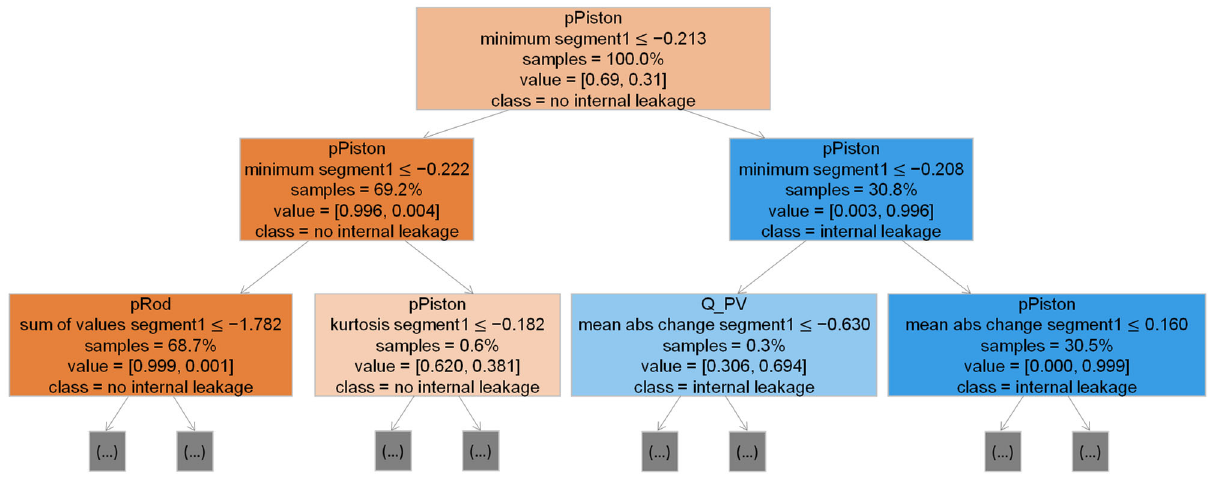
Figure 7. First two levels of a decision tree for the classification of internal leakage at the cylinder. Threshold values relate to features scaled by means of standardization.